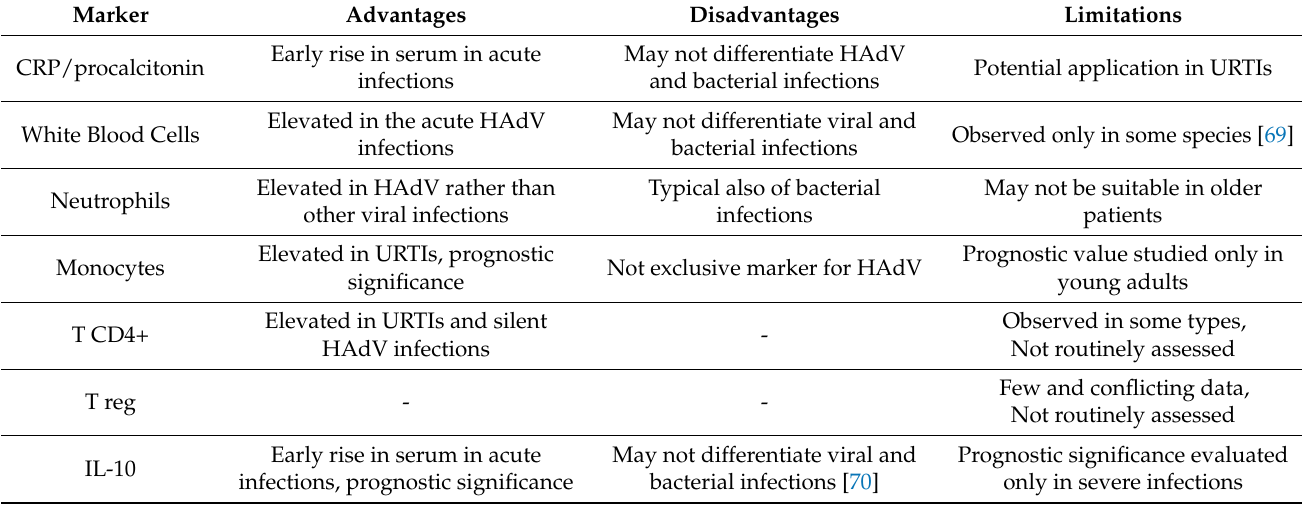
Table 2. Principal serum markers and their clinical impact in diagnosis and management of HAdV infections in children and young adults. CRP = C reactive protein, HAdV = human adenovirus, URTIs = upper respiratory tract infections, humans. Between general infection sites and HAdV species. Other HAdV species may also occur at the site of infection, T CD4+ =